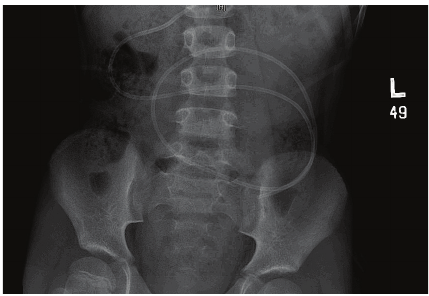
Figure 2: Abdominal X-ray showing the peritoneal catheter with early large knot formation.